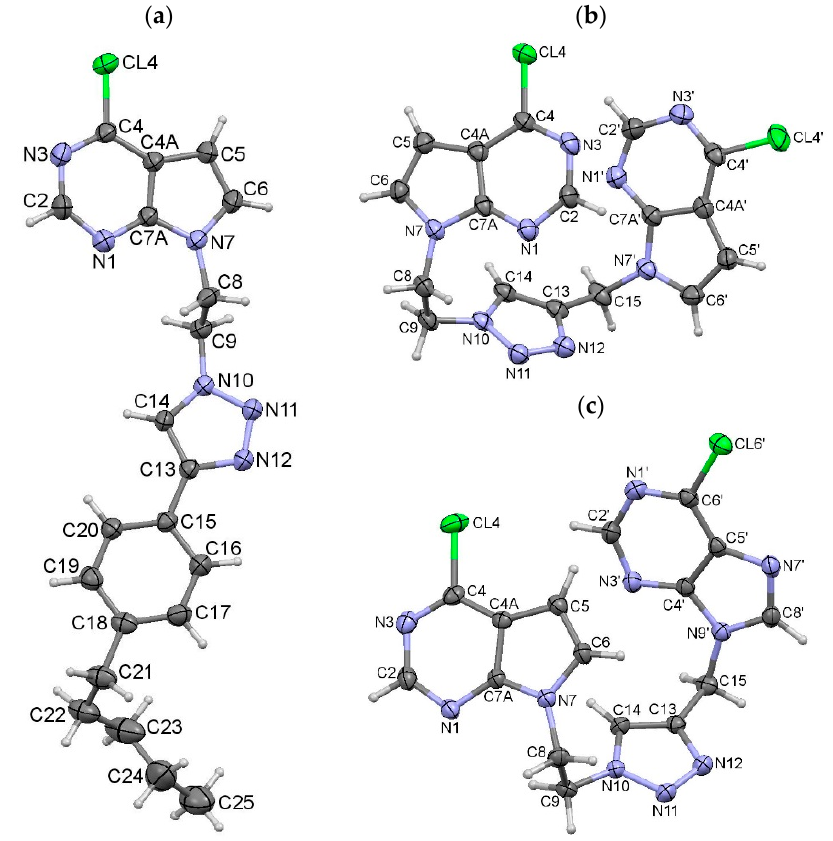
Figure 3. Molecular structures of 4g ( a ), 5a ( b ), and 5b ( c ), with the atom-numbering schemes. Displacement ellipsoids for non-hydrogen atoms are drawn at the 30% probability level. Color code: blue, N; green, Cl; dark grey, C; light grey, H.